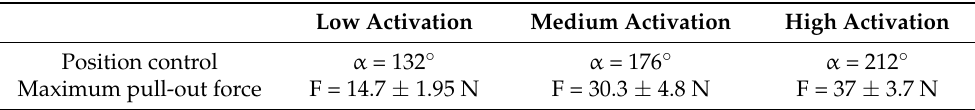
Table 6. Maximum pull-out force (mean and variance) for three increasing values of